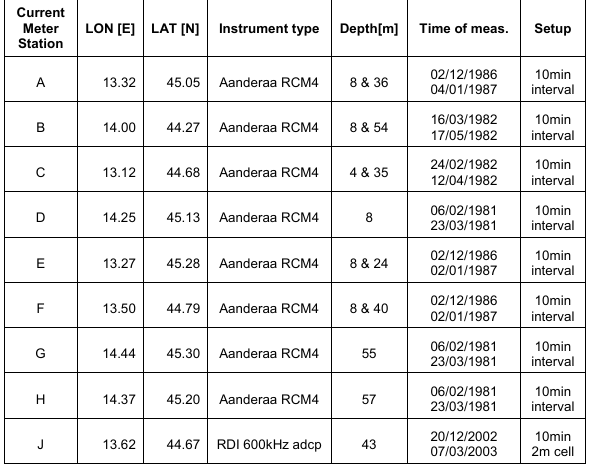
Table 2. Current meter stations from which data were used in this study with deployment details.